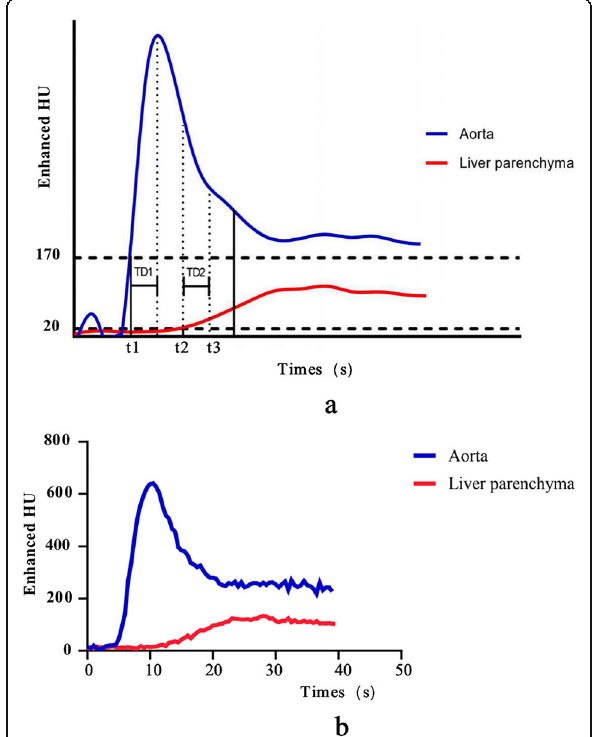
Fig. 1 Time density curves (TDC) of the aorta and liver parenchyma.